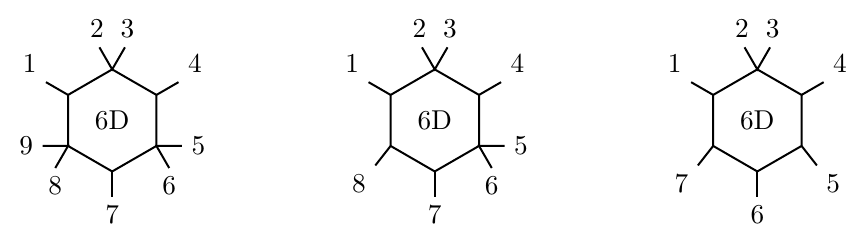
Figure 3 . Three-mass-easy 6 D hexagon and its